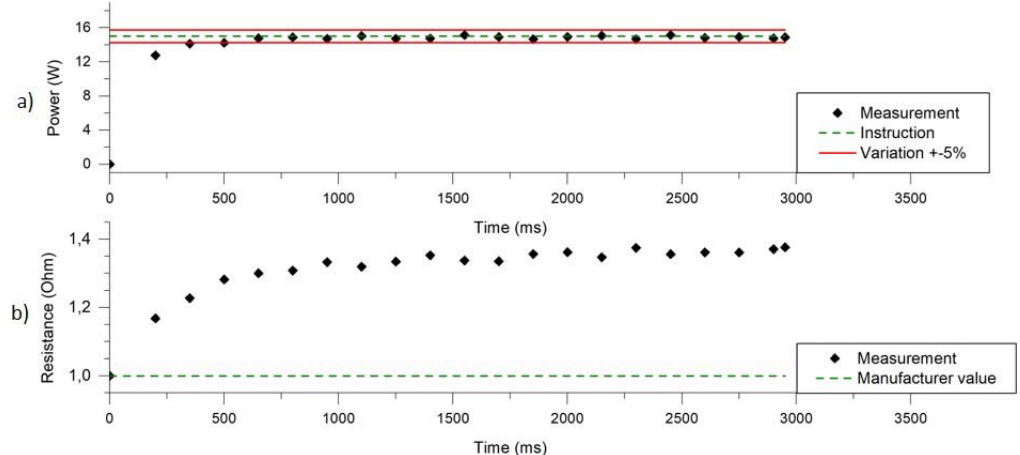
Figure 4. Power applied to the resistor ( a ) and resistor value ( b ) during a typical puff.